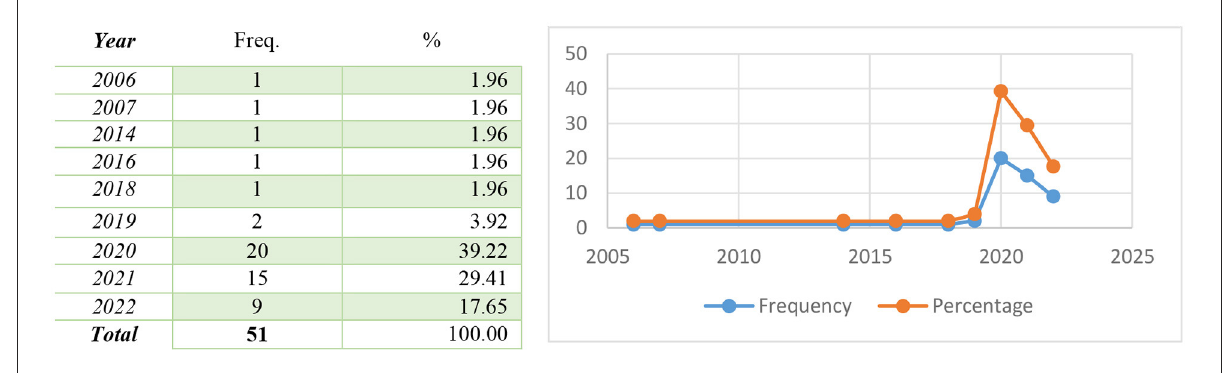
FIGURE2 Distribution of the articles